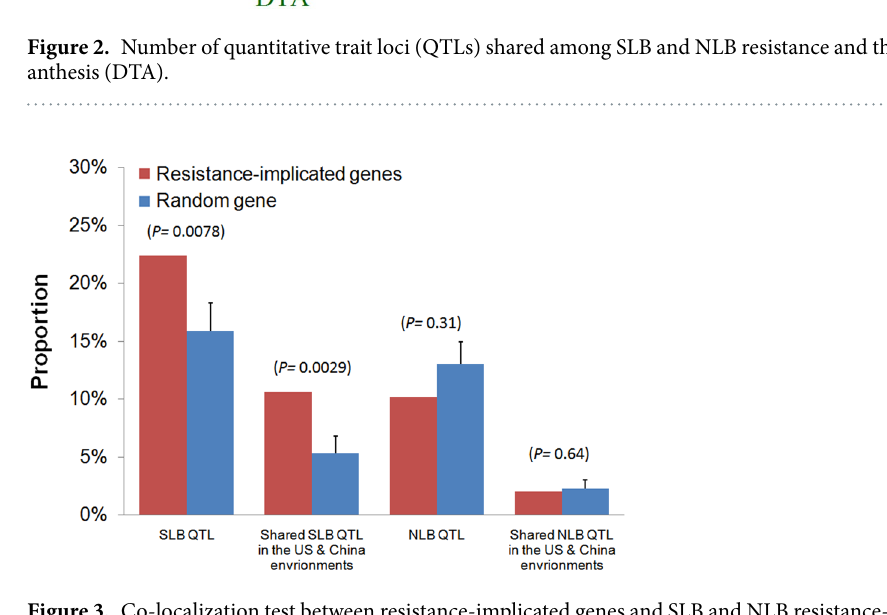
Figure 3. Co-localization test between resistance-implicated genes and SLB and NLB resistance-related unique QTLs. Co-localization is demonstrated as the difference between the observed (red bars) and expected (blue bars) proportions of resistance-implicated genes within QTL regions for SLB or NLB resistance. The expected proportion was derived from a number of randomly selected genes equal to the number of the observed resistance-implicated genes. The random process was replicated 1000 times. The standard errors were used for statistical tests and are displayed for the corresponding